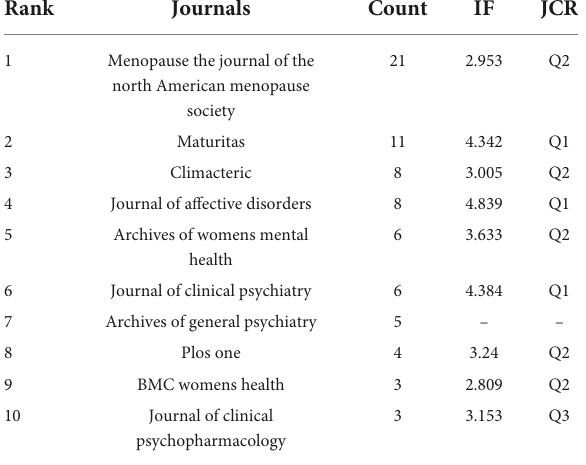
TABLE 7 Top 10 journals related to PMD.